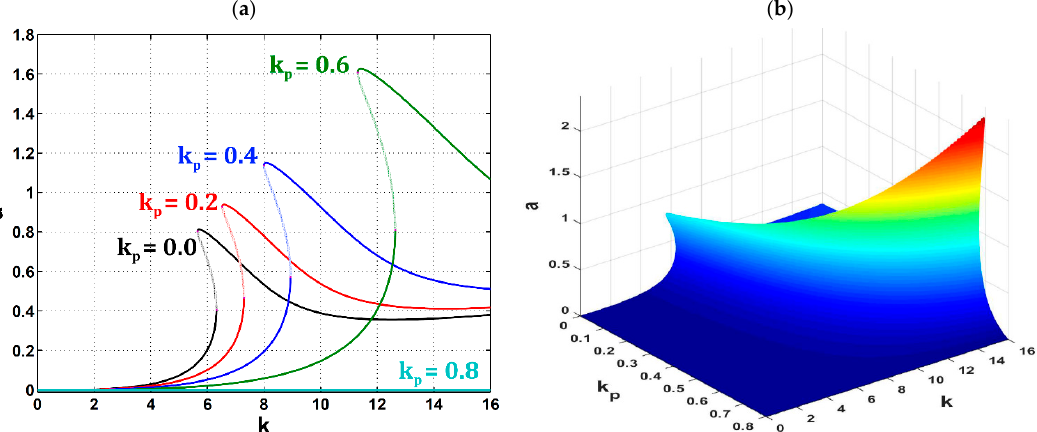
Figure 11. Relationship between the car’s oscillation amplitude a and ( a ) the excitation amplitude k at different values of CP control gain k p , ( b ) both the excitation amplitude k and CP control gain k p post-control ( k v = 0).